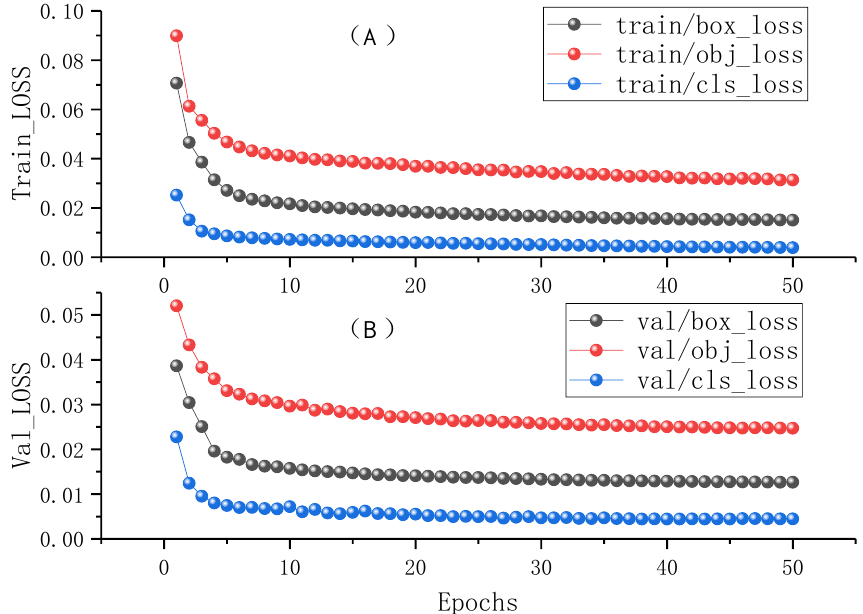
Figure 5. Convergence of the loss functions of training and validation sets. ( A ) Training loss ( B ) Validation loss.